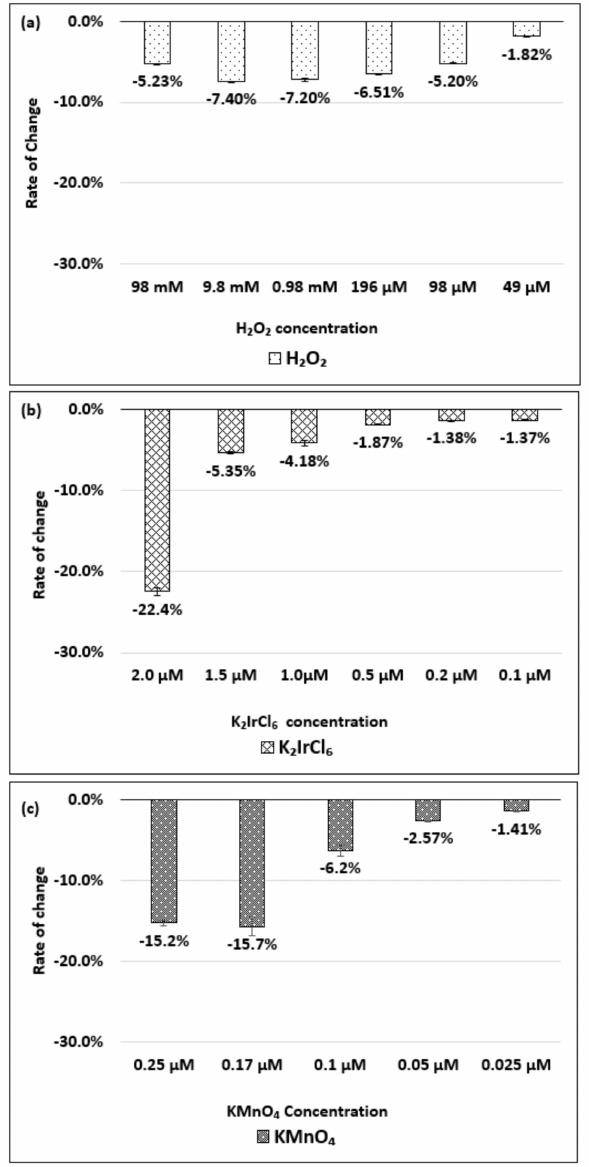
Figure 7. Absorbance change for the (9,4) chirality of the dsDNA-HiPco SWNT complex, relative to the initial state, based on the concentration of the ( a ) H 2 O 2 , ( b ) K 2 IrCl 6 , and ( c ) KMnO 4 . The data are presented as the average of three independent